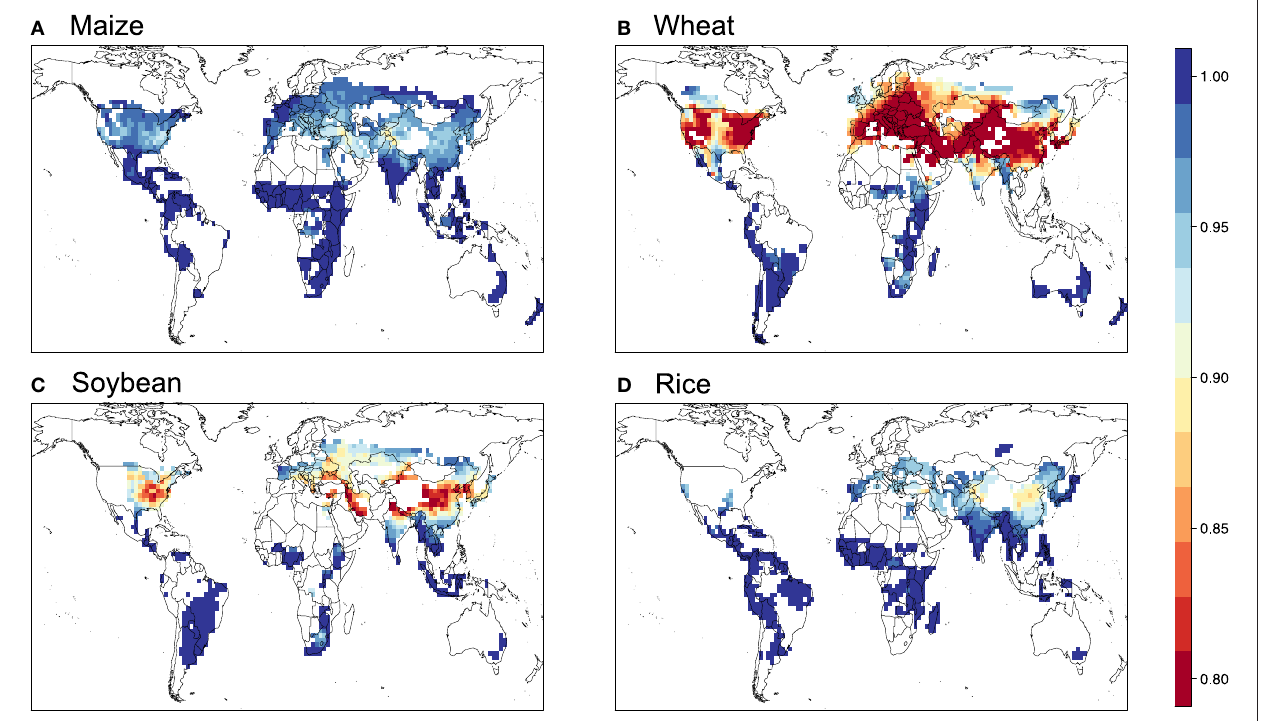
FIGURE 5 | Relative yield based on the AOT40 metric for (A) maize, (B) wheat, (C) soybean, and (D) rice.